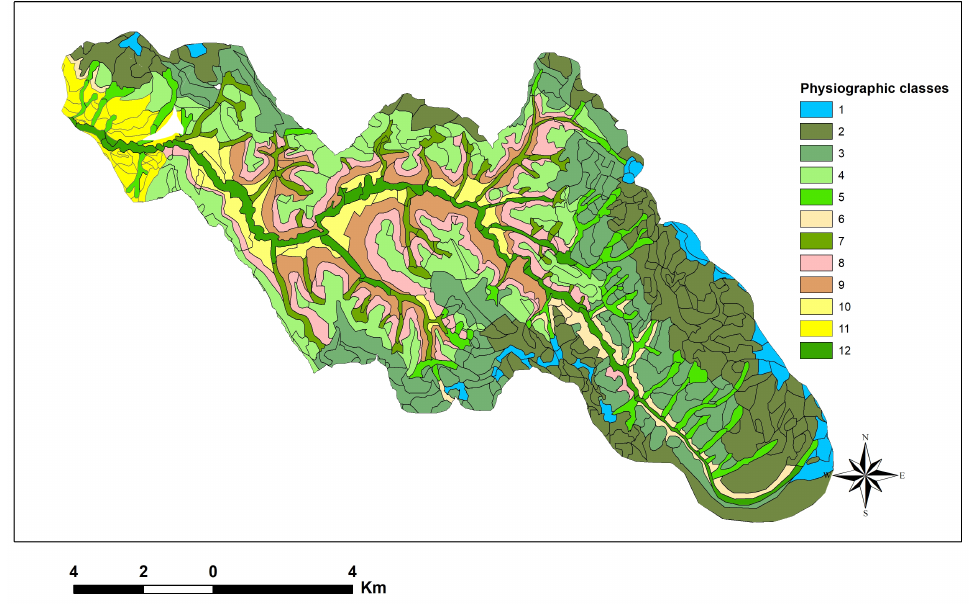
Figure 3. Landscape units in the Zayachya river basin [45]. Physiographic classes (number of urochishche types in brackets): 1-boggy depressions on interfluves (13); 2-flat poorly-drained interfluves composed of morainic loams (30); 3-slightly inclined interfluves with thin (5–20 cm) cover of loamy sands over morainic loams (14); 4-well-drained narrow interfluves with thick (20–50 cm) cover of loamy sands over morainic loams (20); 5-gullies with gentle slopes incised into morainic loams (17); 6-gentle slopes of river valleys composed of loams (7); 7-gullies and small rivers incised into marls (7); 8-steep slopes with exposure of marls (15); 9-deluvial trains (11); 10-well-drained sandy terraces (4); 11-glaciofluvial plains with aeolic landforms (18); 12-floodplains (14).